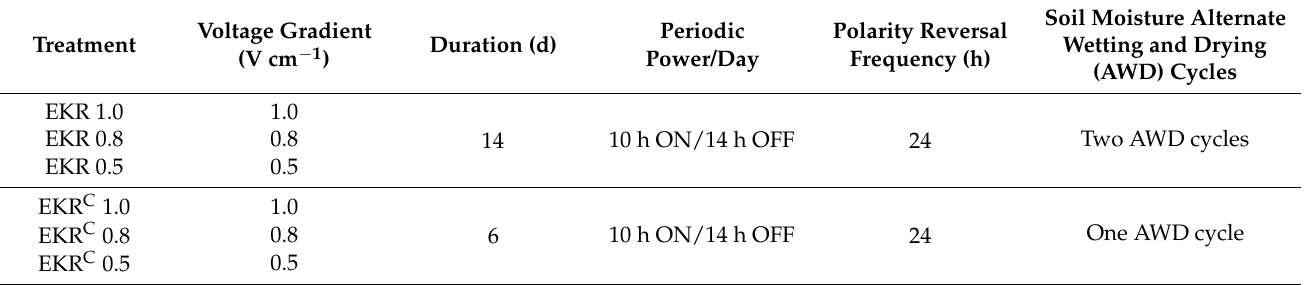
Table 1. Summary of experimental